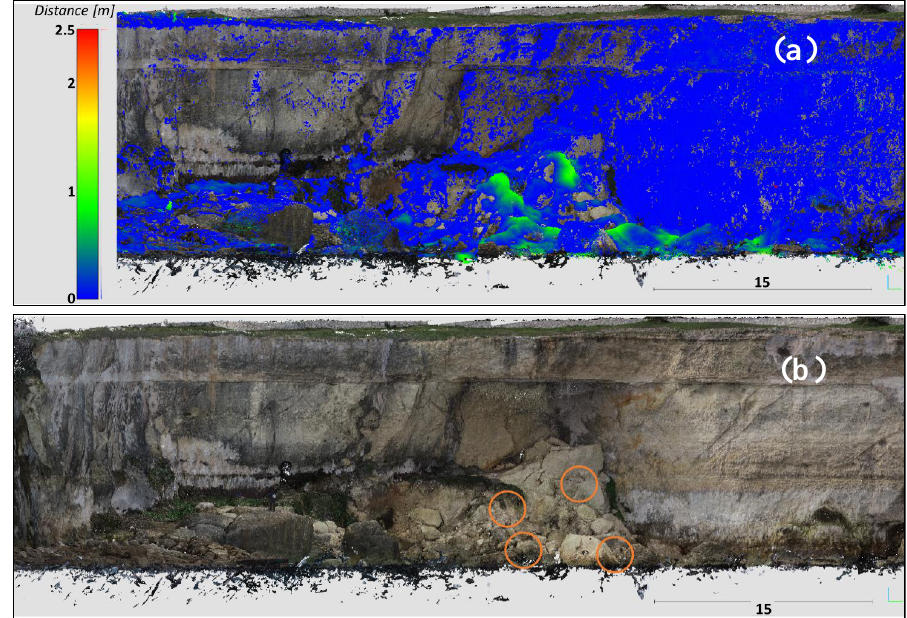
Figure 9. ( a ) Change detection overlayed on F19: Green areas depict sectors affected by the erosion; ( b ) point cloud F19: Highlighted sectors (orange circles) featuring erosive processes.